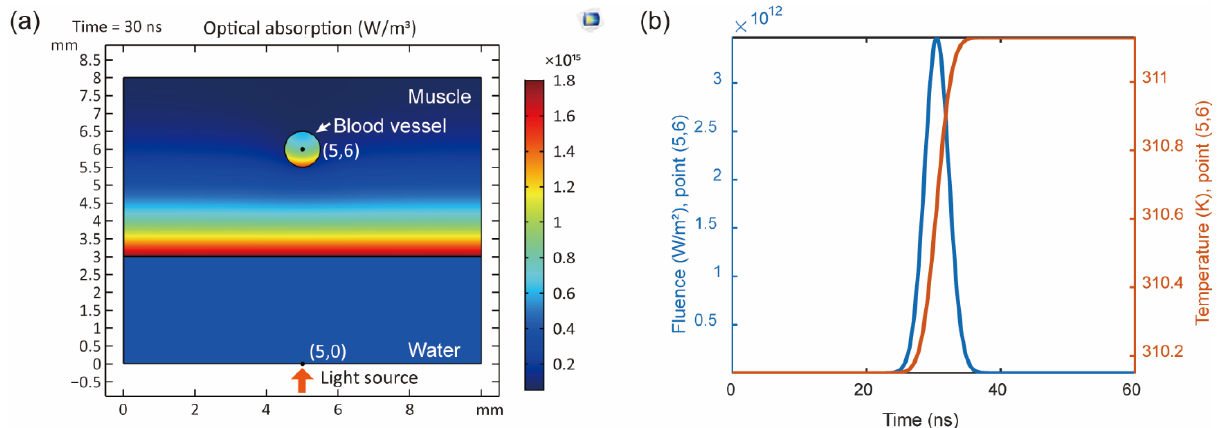
Figure 6. Simulation results of photoacoustic imaging for lung tissues: ( a ) Optical absorption at 30 ns, ( b ) Optical fluence and temperature change from 0 – 60 ns at points (5, 6).